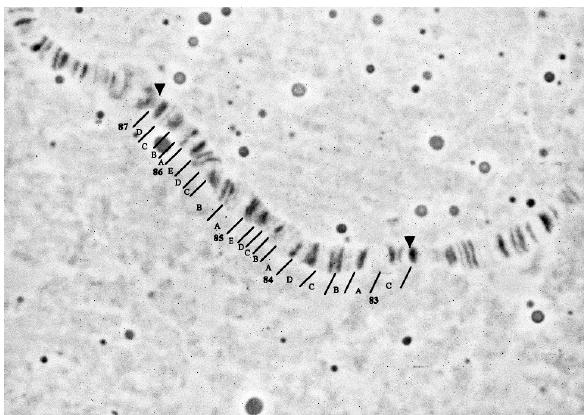
Figure 3 - Pattern of bands of the O 5 chromosomal inversion in the homokaryotypes O 5 /O 5 . 1000X. Arrows indicate the breakage points of the inversion.